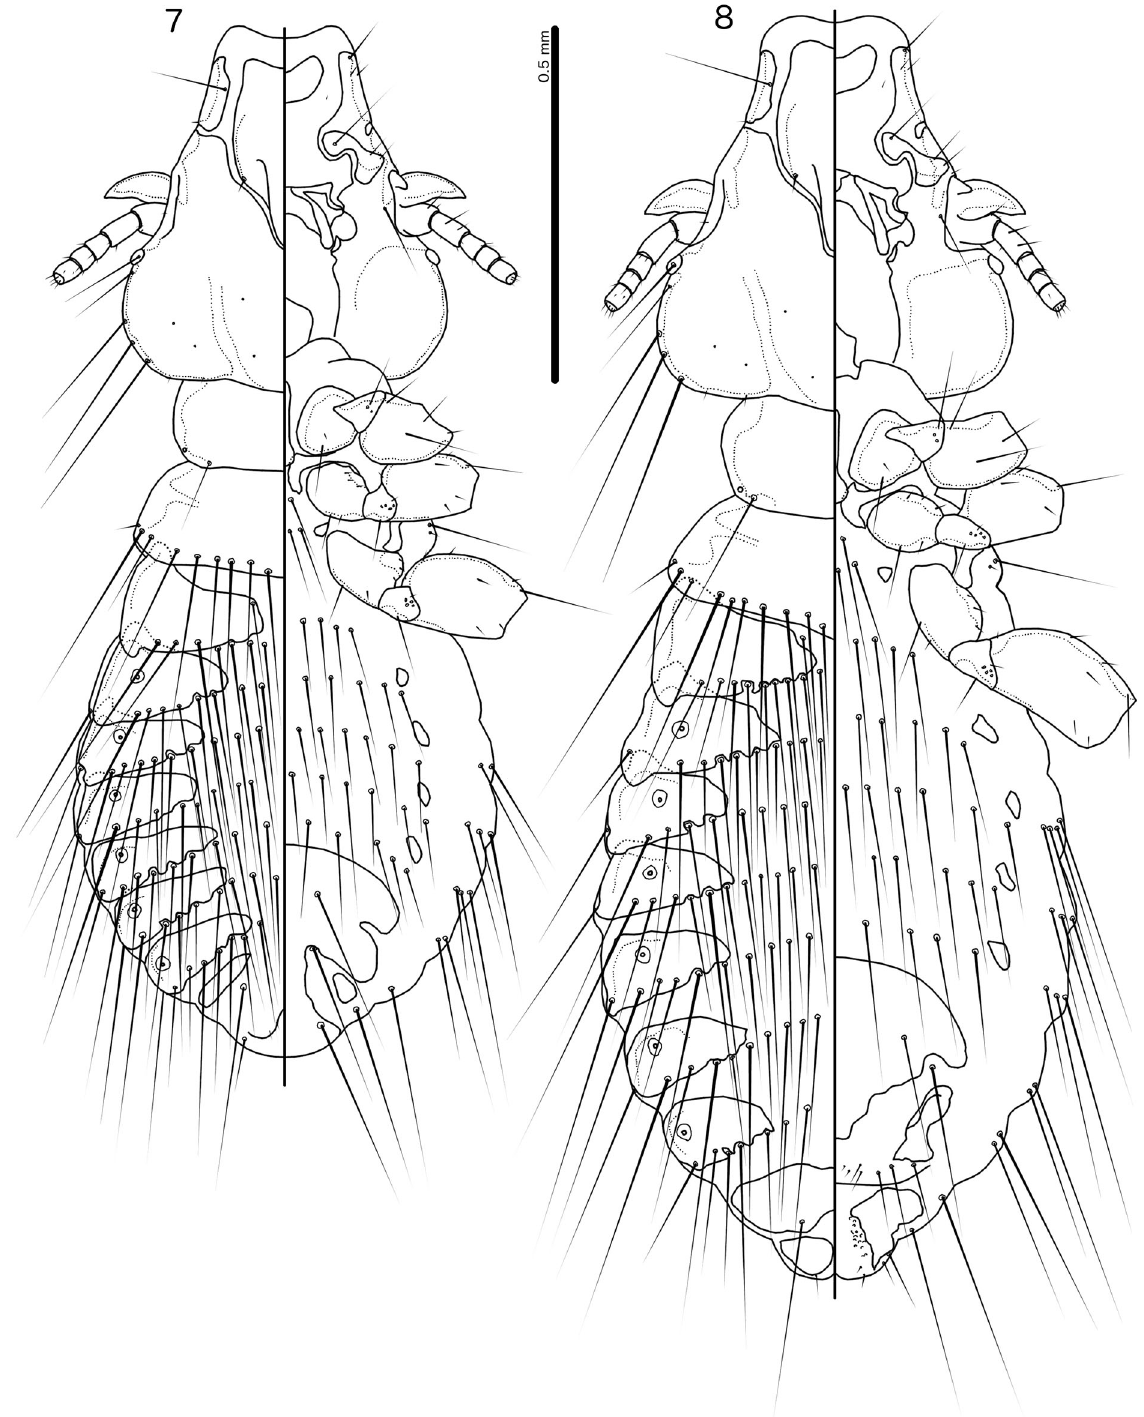
Figs 7–8. Philopterus micropunctatus sp. nov. ex Anthus hodgsoni Richmond, 1907. 7 . Male habitus, dorsal and ventral views. 8 . Female habitus, dorsal and ventral